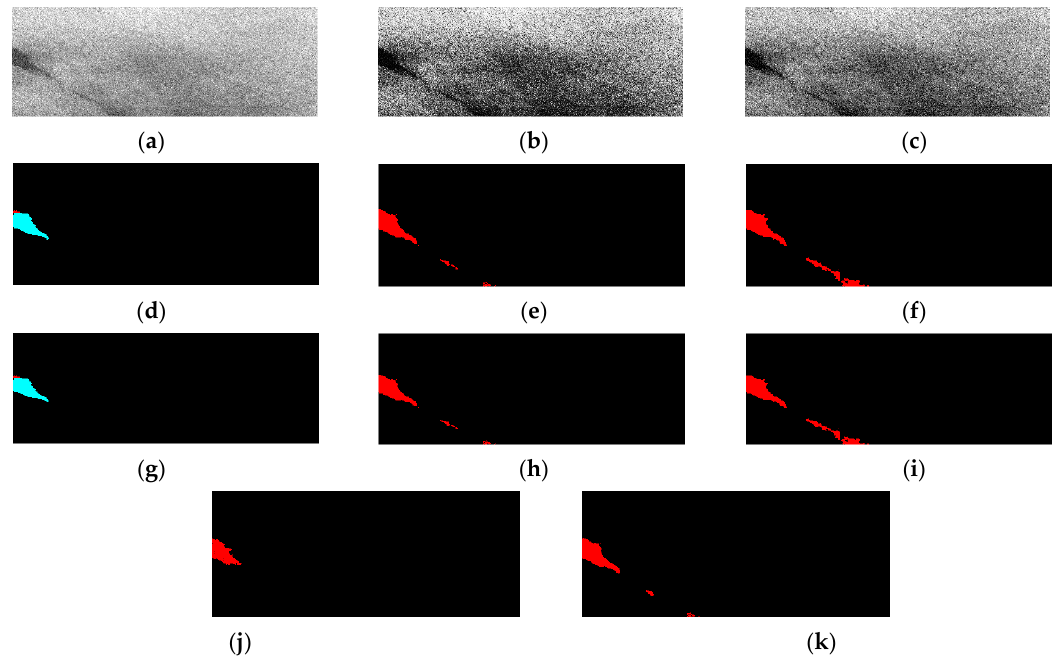
Figure 11. Example 2 of the different predictions created by the models: ( a ) original image; ( b ) image with histogram equalization; ( c ) image with contrast stretch; ( d ) DeepLabv3+ prediction; ( e ) DeepLabv3+ with histogram equalization prediction; ( f ) DeepLabv3+ with contrast stretch prediction; ( g ) Unet prediction; ( h ) Unet with histogram equalization prediction; ( i ) Unet with contrast stretch prediction; ( j ) ground truth; ( k ) ensemble model prediction.